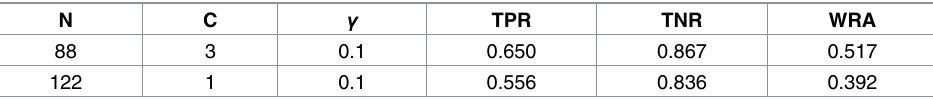
PLOS ONE | https://doi.org/10.1371/journal.pone.0185417 September 27,